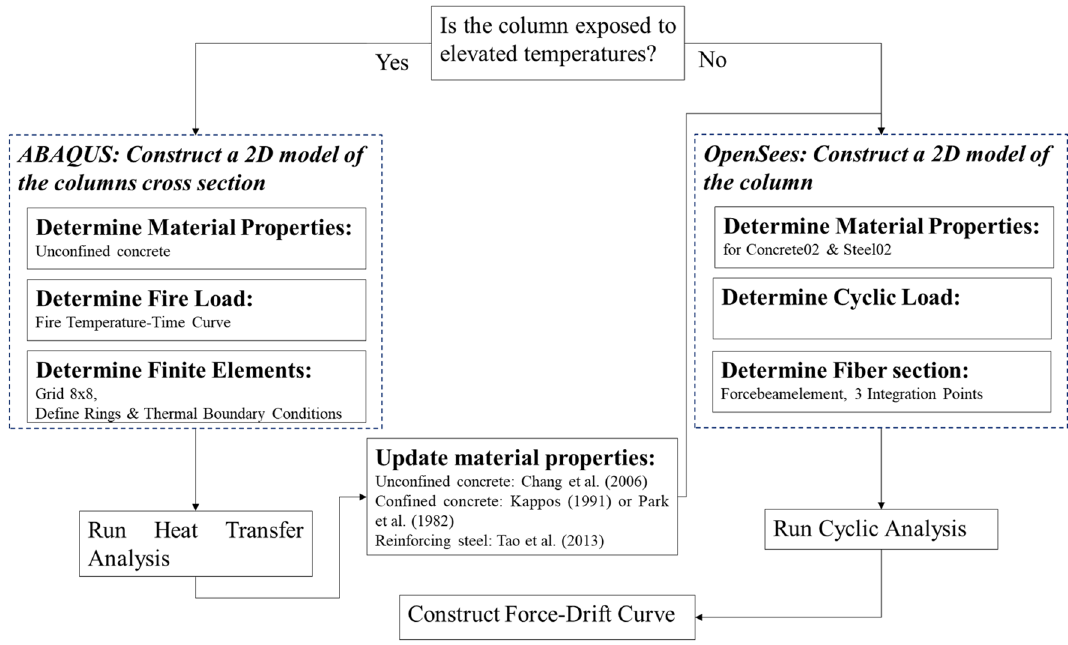
Figure 1. The framework proposed in this study in order to model the post-fire seismic behaviour of a non- seismically designed RC